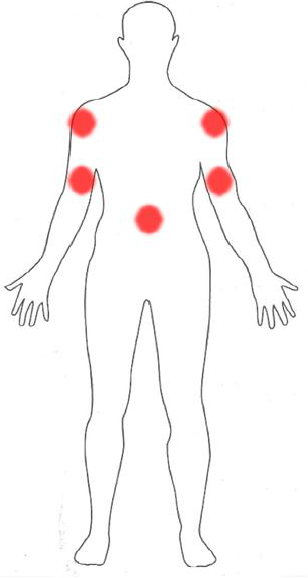
Figure 2. Muscle activity measurement F igure 2. Muscle activity measurement map. 2.1. Blueberry Harveating Method